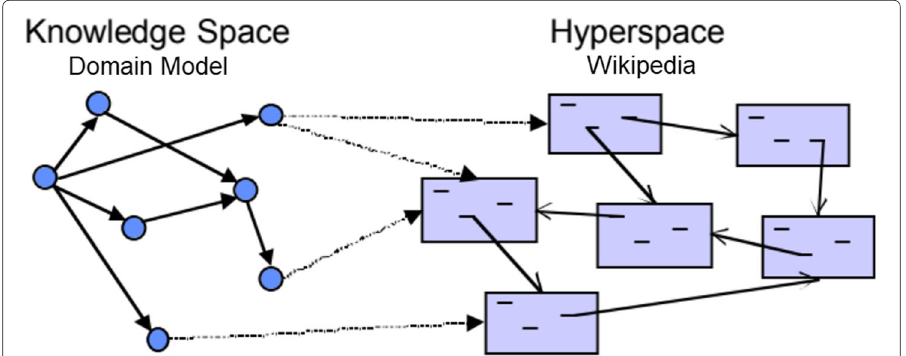
Fig. 3 Connections between the Domain Model and the Hyperspace (Araújo